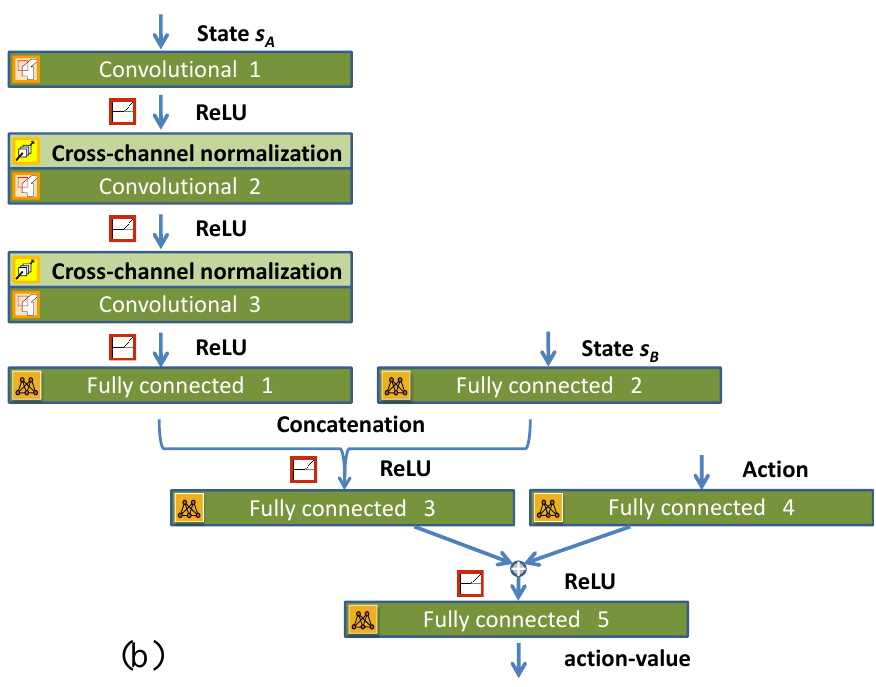
Figure 4. Network structure: ( a ) actor network; ( b ) critic network.